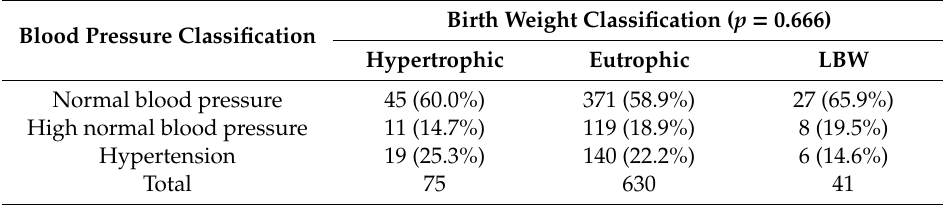
Table 5. Birth weight category versus hypertension in the